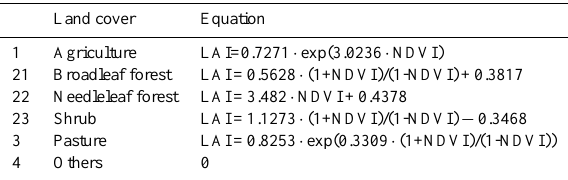
Table 2. Relationship between NDVI and LAI after Zhang et al.,